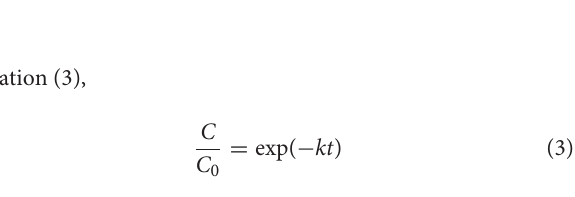
FIGURE 9 | Evolution of the UV-vis absorption spectra during the reduction of